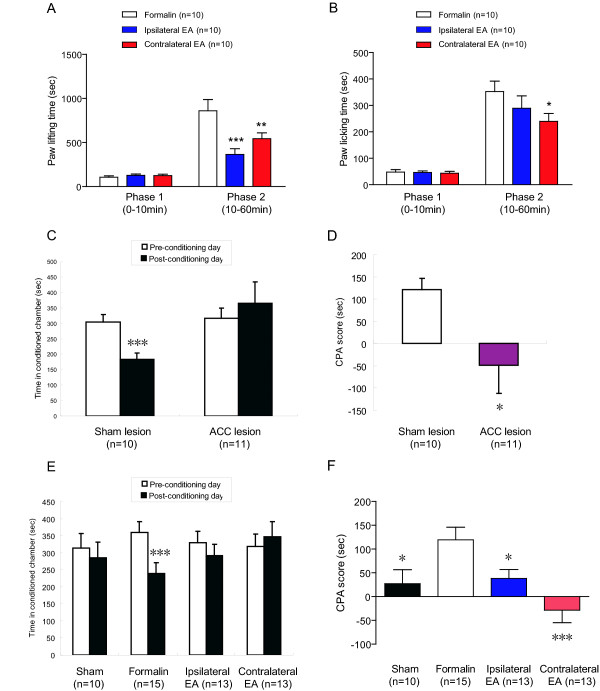
Effects of ipsilateral or contralateral EA on pain sensation and affection in the formalin model. A, Either ipsilateral or contralateral EA significantly decreased the paw lifting time in the second phase of the formalin test. B, Contralateral but not ipsilateral EA reduced paw licking time in the second phase. C, ACC lesions reversed F-CPA, which was a significant decrease of the time spent in the formalin-paired compartment. D, ACC lesions significantly decreased CPA scores. E, F-CPA was reversed by either ipsilateral or contralateral EA. F, Either ipsilateral or contralateral EA significantly decreased CPA scores. * p < 0.05; ** p < 0.01; *** p < 0.005 compared with the formalin group (A, B, D and F) and between pre-conditioning and post-conditioning days (C and E). All data were presented as means ± SEM.